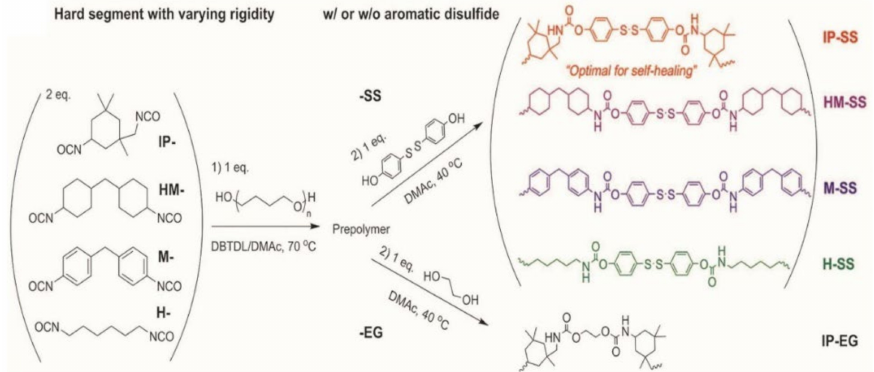
Figure 7. Synthetic routes to TPUs with four different diisocyanates (i.e., IP, HM, M, and H) and two chain extenders (i.e., SS and EG). The TPUs are designated as X–Y, where X and Y denote the abbreviation of the diisocyanate monomer and chain extender, respectively. Reproduced with permission from [104]. Copyright 2017 WILEY-VCH Verlag GmbH & Co. KGaA, Weinheim.